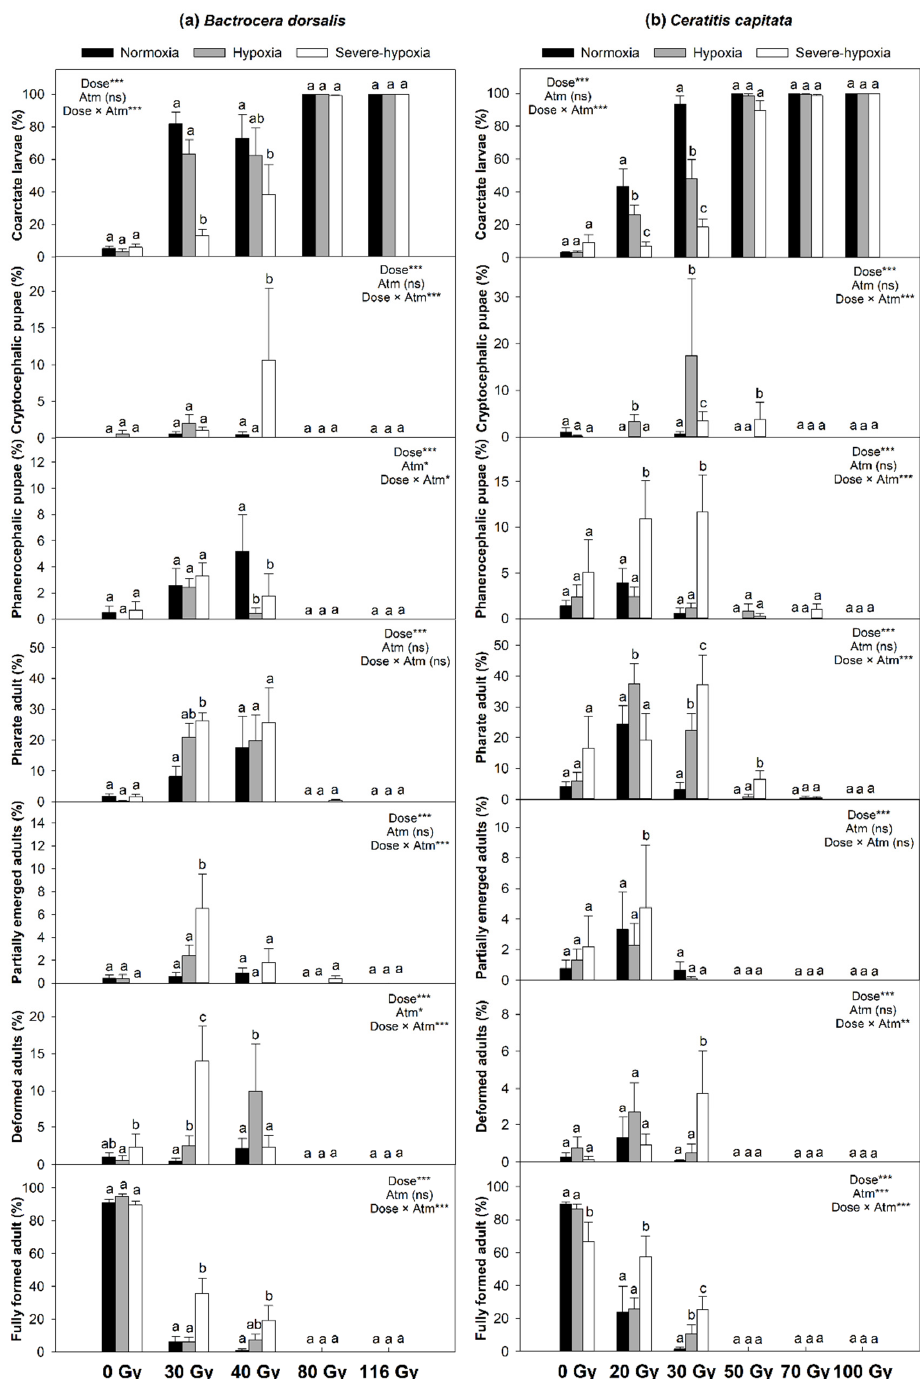
Figure 2. Percentages (mean ± SE) of dead insects dissected from puparia and emerged adults of ( a ) B. dorsalis and ( b ) C. capitata after irradiation of third instars at di ff erent nominal doses and atmospheric conditions and their controls. GLMM models for the e ff ect of dose, atmosphere (atm), and their interaction on each developmental stage (‘***’ p < 0.0001, ‘**‘ p = 0.001, ‘*’ p < 0.05, ns = non-significant). Bars followed by di ff erent letters within the same radiation dose are significantly di ff erent from each other ( p < 0.05). Details in Table S9 ( B. dorsalis ) and Table S10 ( C. capitata